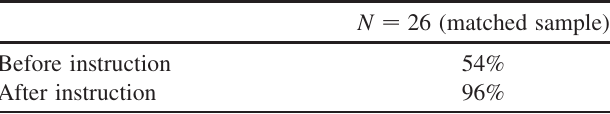
TABLE IV. Appropriate KSI. Performance comparison of graduate students in displaying appropriate KSI on electric circuits as a result of instruction in the graduate course. (See Fig. 1 for before instruction and Fig. 2 for after instruction questions.)